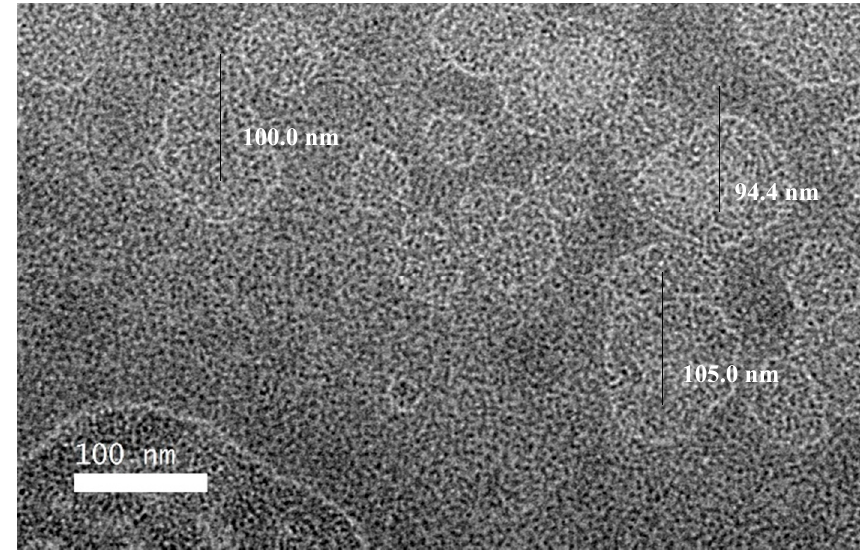
Figure 4. The TEM images of the KMO formulation from the 100 nm view.